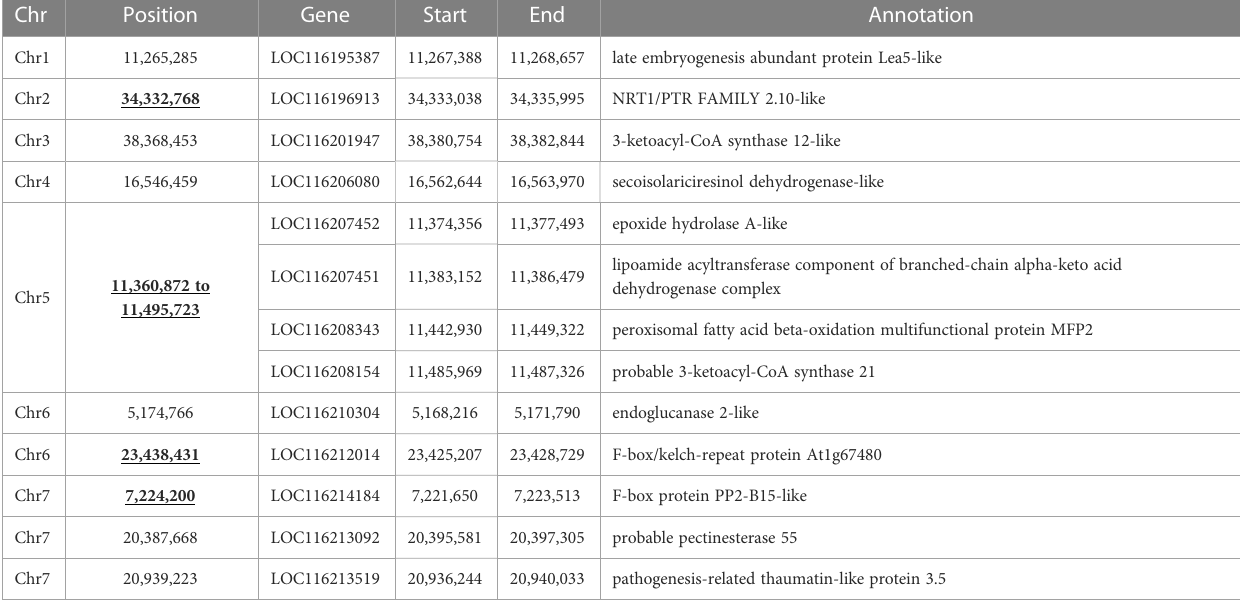
TABLE 2 Genomic regions that showed high diversion between soft- and hard-seeded cultivars. Loci with underlined chromosome positions are the loci that are common with the one detected in Luo et al.